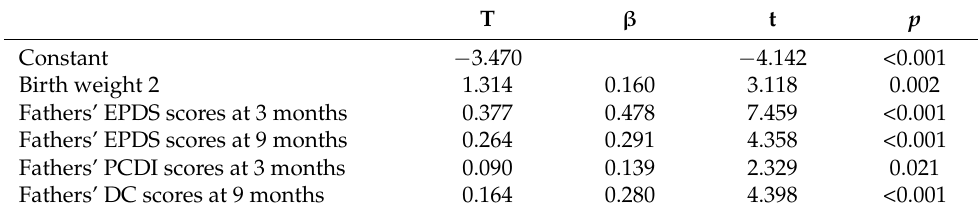
Figure 3. Fathers’ PSI-subscales scores related to birth weight and time of assessment. Note. ELBW = extremely low birth weight; VLBW = very low birth weight; FT = full-term; T1 = 3 months; T2 = 9 months; T3 = 12 months. * p < 0.05. ** p < 0.005. Table 3. Regression model identifying predictors of fathers’ EPDS scores at 12